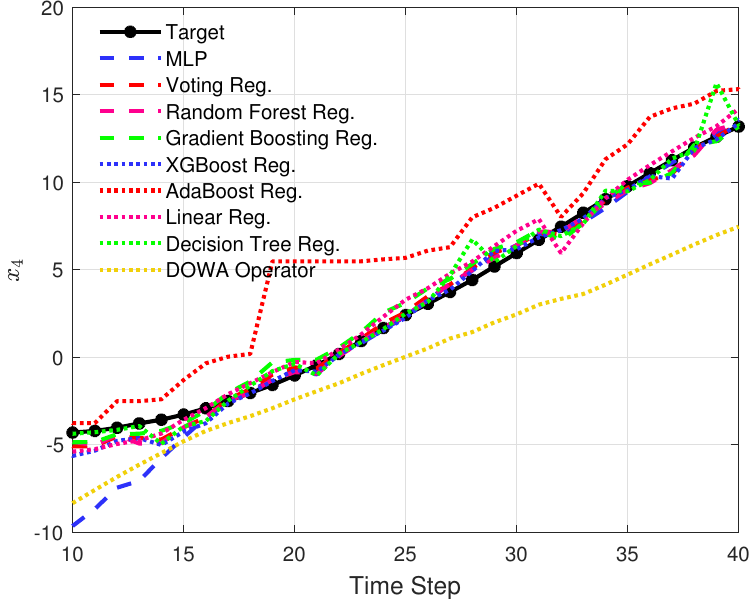
Figure 17. Fusion results for one Monte Carlo simulation for state 4 (zoomed